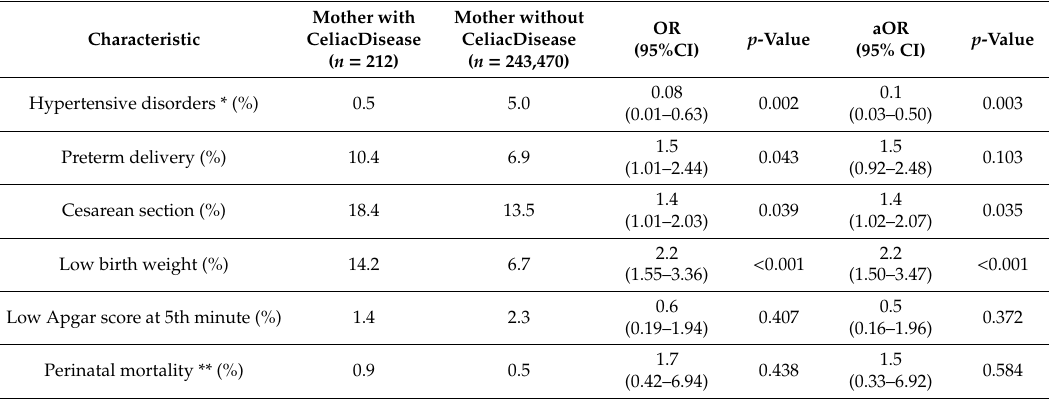
Table 2. The association between maternal celiac disease and adverse perinatal outcome; univariable analysisandresultsfromgeneralizedestimationequationmodelscontrollingformaternalageandparity.